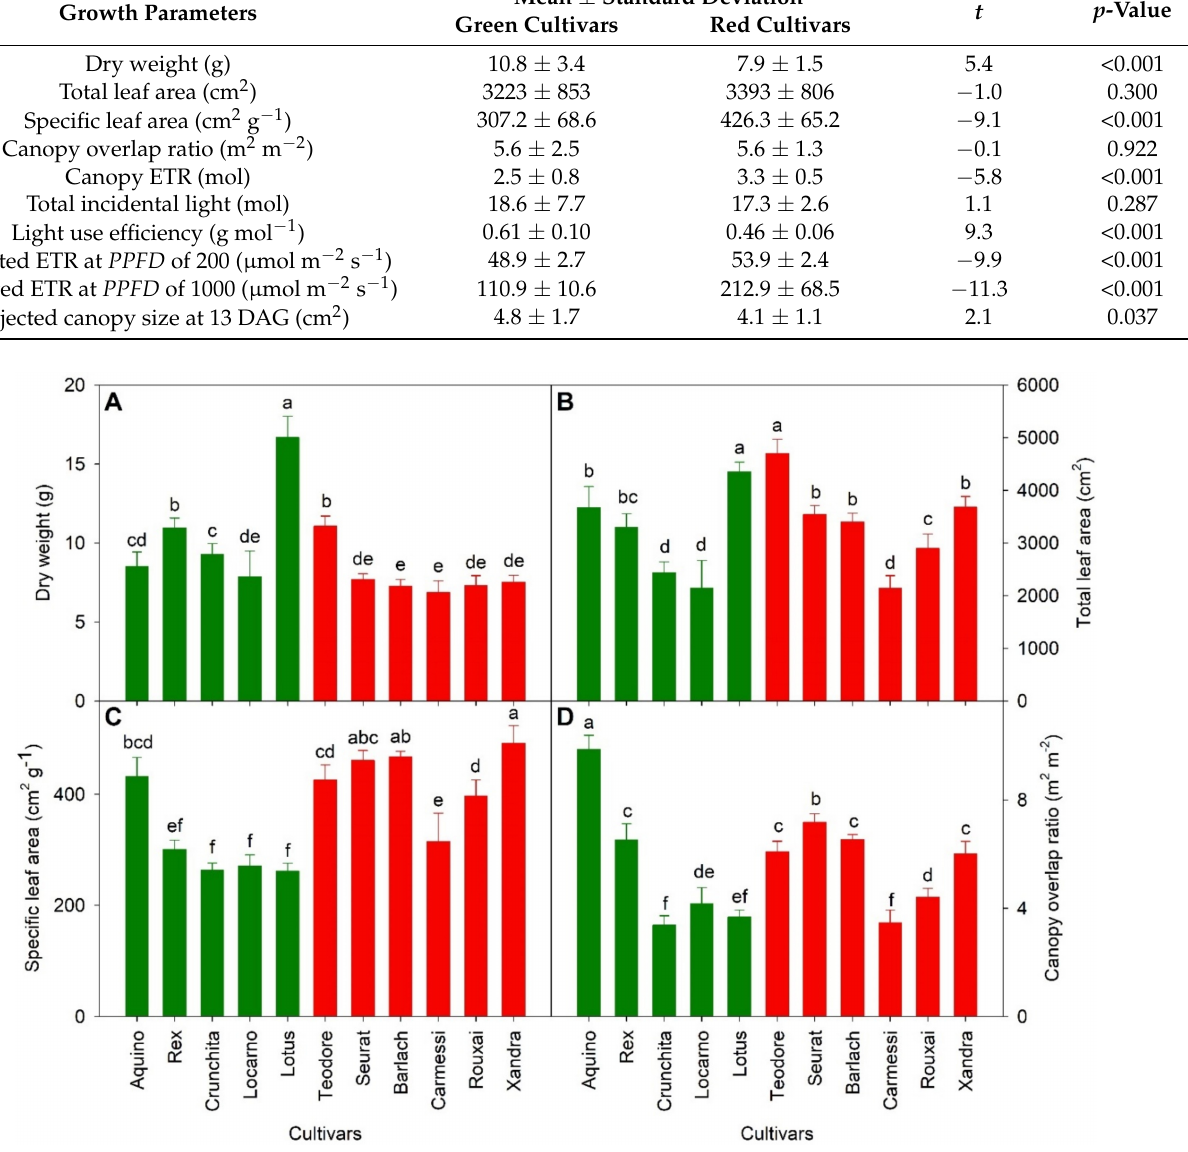
Figure 2. Harvest data of 11 lettuce cultivars collected at 51 days after germination. Green bars indicate cultivars with green leaves, while red bars indicate red cultivars. ( A ) Dry weight; ( B ) Total leaf area; ( C ) Specific leaf area; ( D ) Canopy overlap ratio. Cultivars with the same letter are not significantly different from each other ( p = 0.05, n =